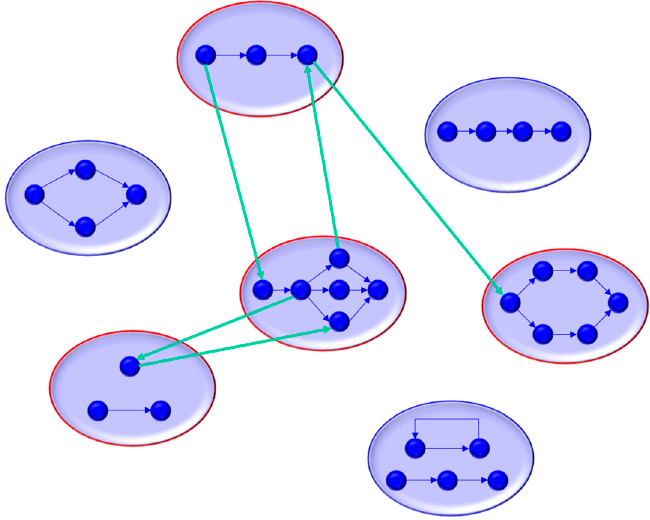
Figure 17. Networked manufacturing process crossing the boundaries of multiple organizations.